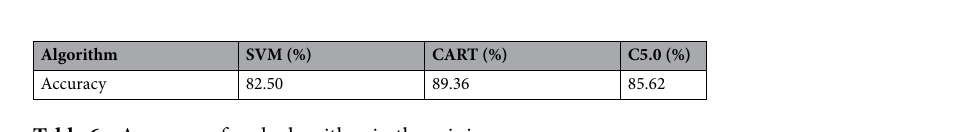
Table 6. Accuracy of each algorithm in the mining area.